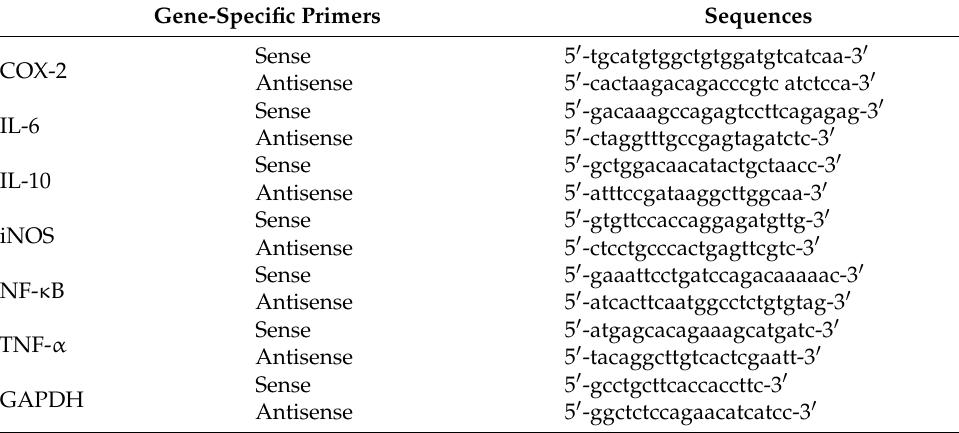
Table 1. The gene-specific primers for RT-qPCR (mouse). Gene-Specific Primers